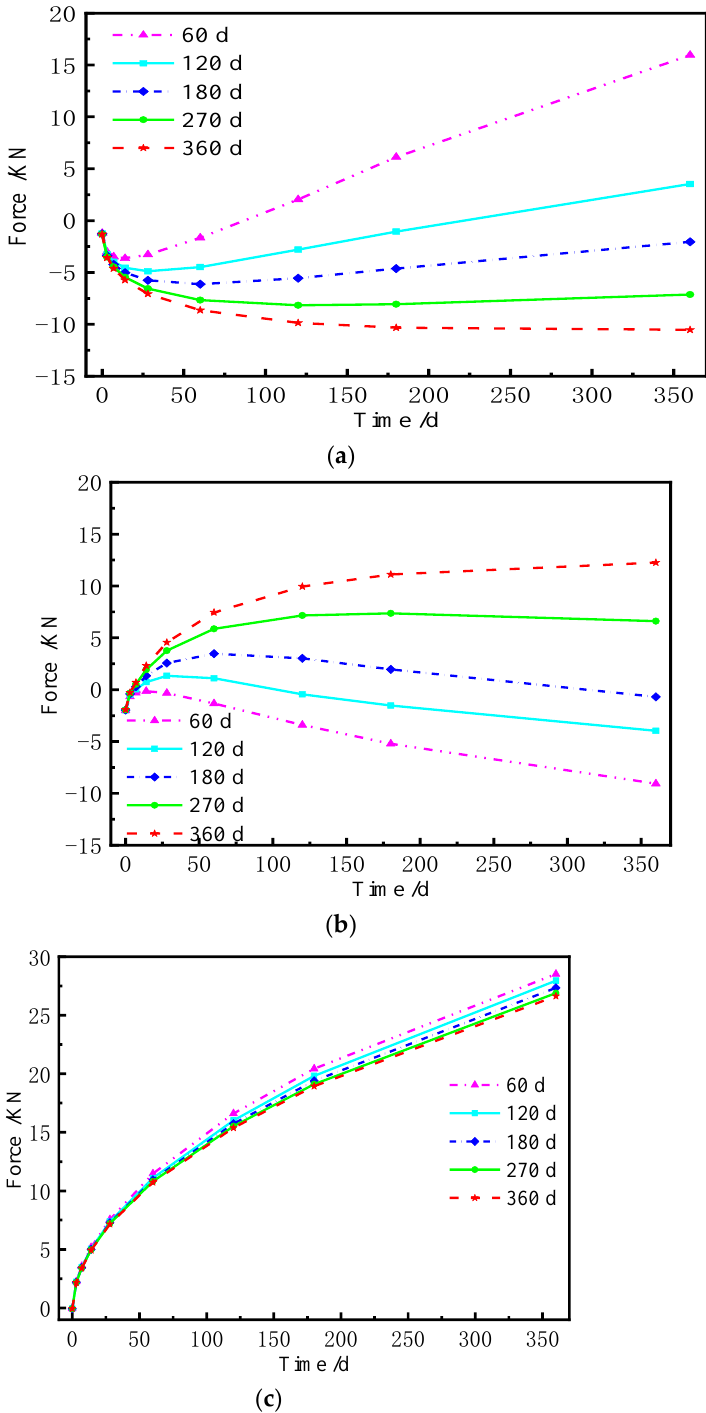
Figure 25. Force time-varying graph of the shear cogging. ( a ) Vertical force at the slab edge. ( b ) Vertical force at the middle of slab. ( c ) Lateral force at the slab edge.